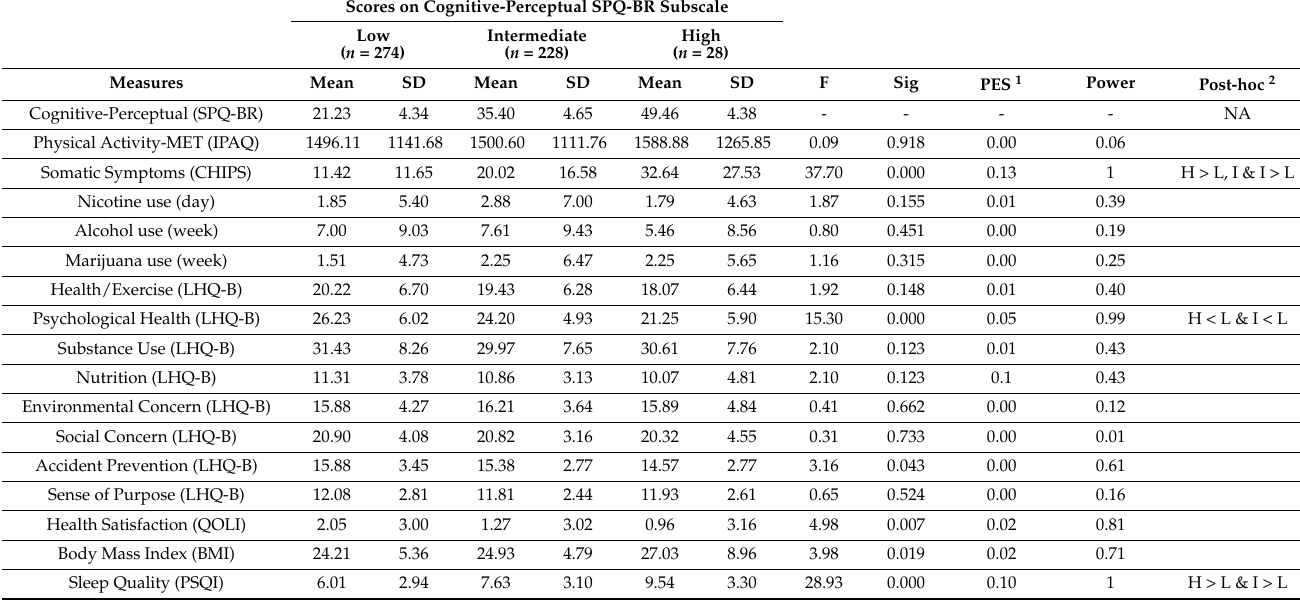
Table 2. Descriptive information for study variables and MANOVA results organized by high, intermediate, and low Cognitive-Perceptual (positive) schizotypy